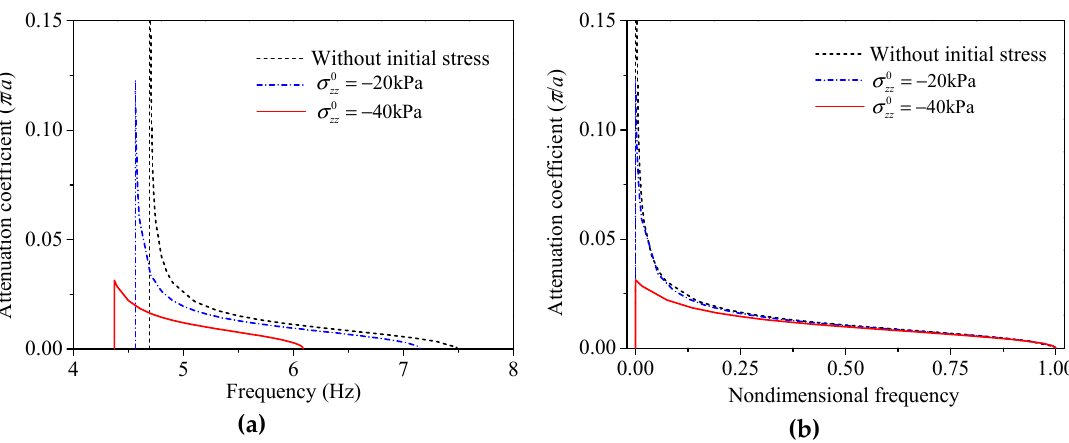
Figure 7. Attenuation coefficients versus ( a ) frequency and ( b ) non-dimensional frequency with different initial stresses.